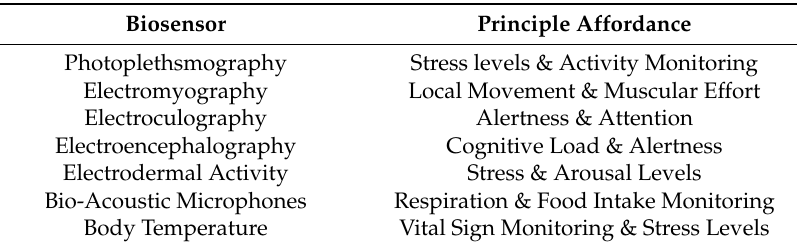
Table 2. Summary of ear-mounted bio signal